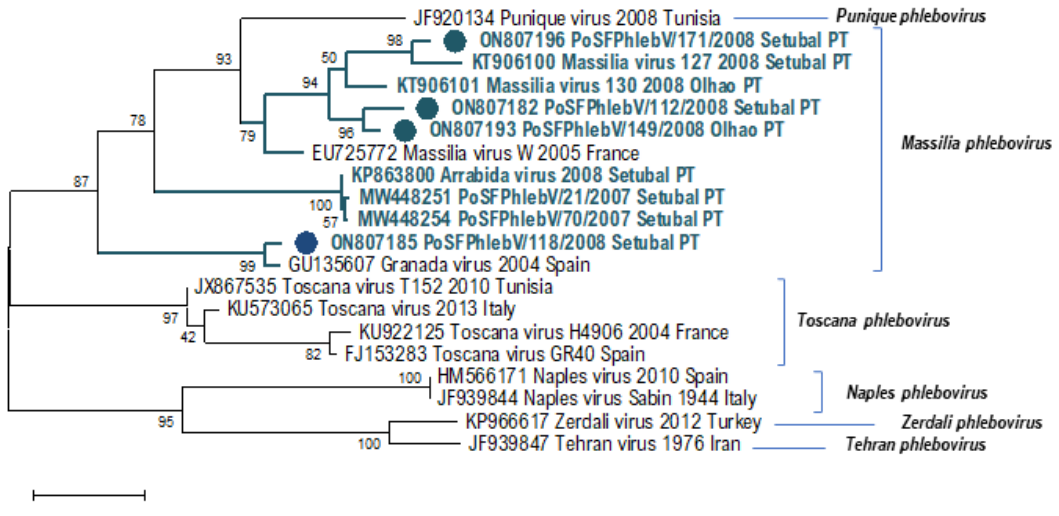
Figure 2. Maximum likelihood phylogenetic tree of phleboviruses partial glycoprotein precursor nucleotide sequences (segment M, 461 positions in the final dataset) using Tamura 3-parameter model and discrete gamma distribution. Sequence names in blue ( Massilia phlebovirus ) were detected in Portugal (PT). Sequence names marked with a colored bullet have been sequenced in this study. Bootstrap support over 60% is presented on branches. Used sequence alignment is available in Supplementary File S2: Phleboviruses’ nucleotide partial sequence alignment of M segments. Names of the sequences in the tree match the IDs in the alignment made available as a Supplementary File.